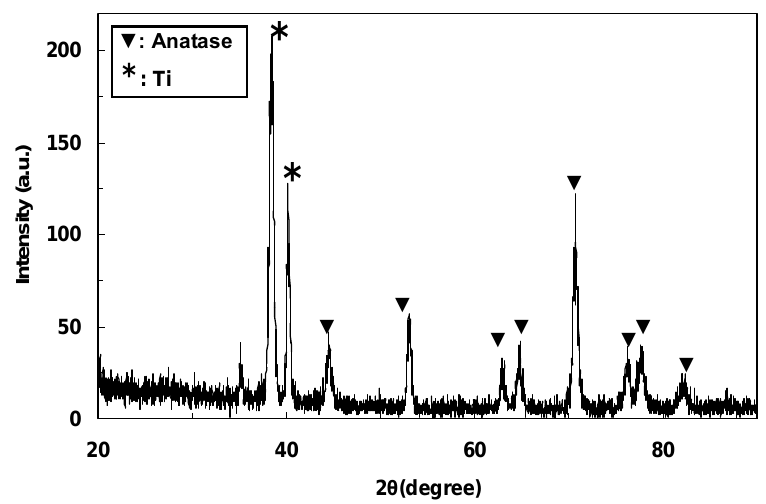
Fig. 3. XRD patterns of TiO